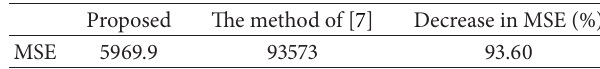
Table 1: MSEs over 3000 frames of the estimated glottal area